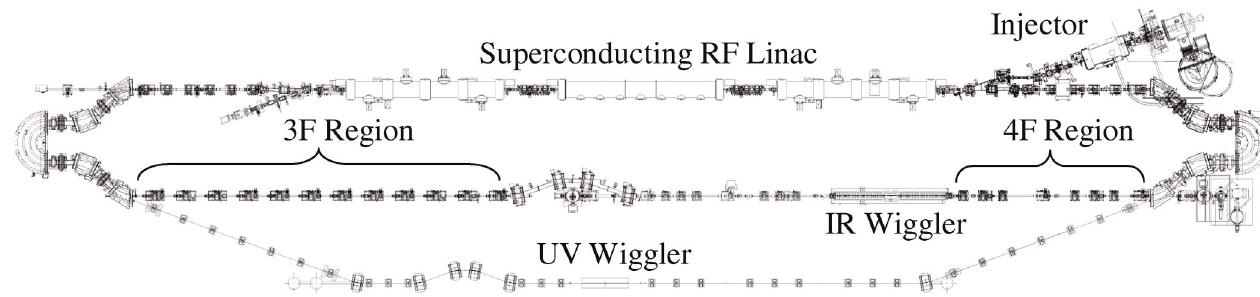
FIG. 1. Layout of the Jefferson Lab FEL 10 kW upgrade (the UV transport line has not yet been